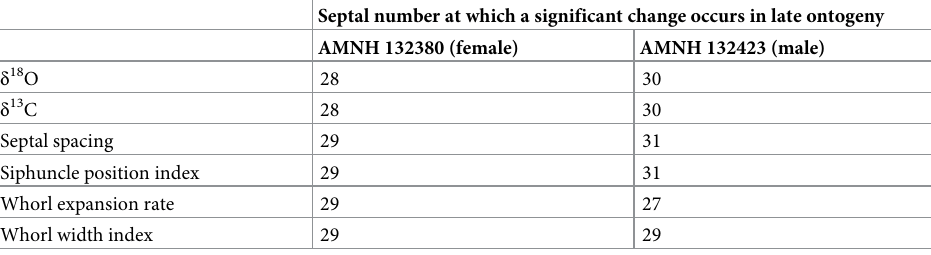
Table 1. Comparison of the onset of maturity and changes in isotope composition of the septa. Septal number at which a significant change occurs in late ontogeny AMNH 132380 (female)